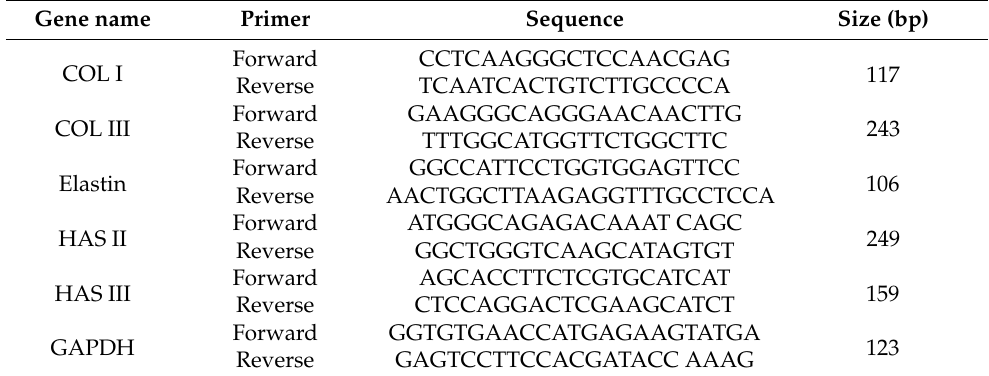
Table 1. Primer sequences of COL I, COL III, HAS II, HAS III, Elastin, and